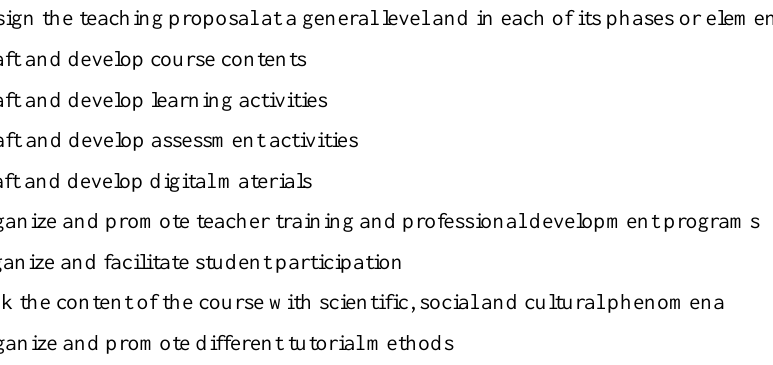
Figure 1. Comparison between the proficiency level and the training needs for the acquisition of pedagogical competencies within the e-learning